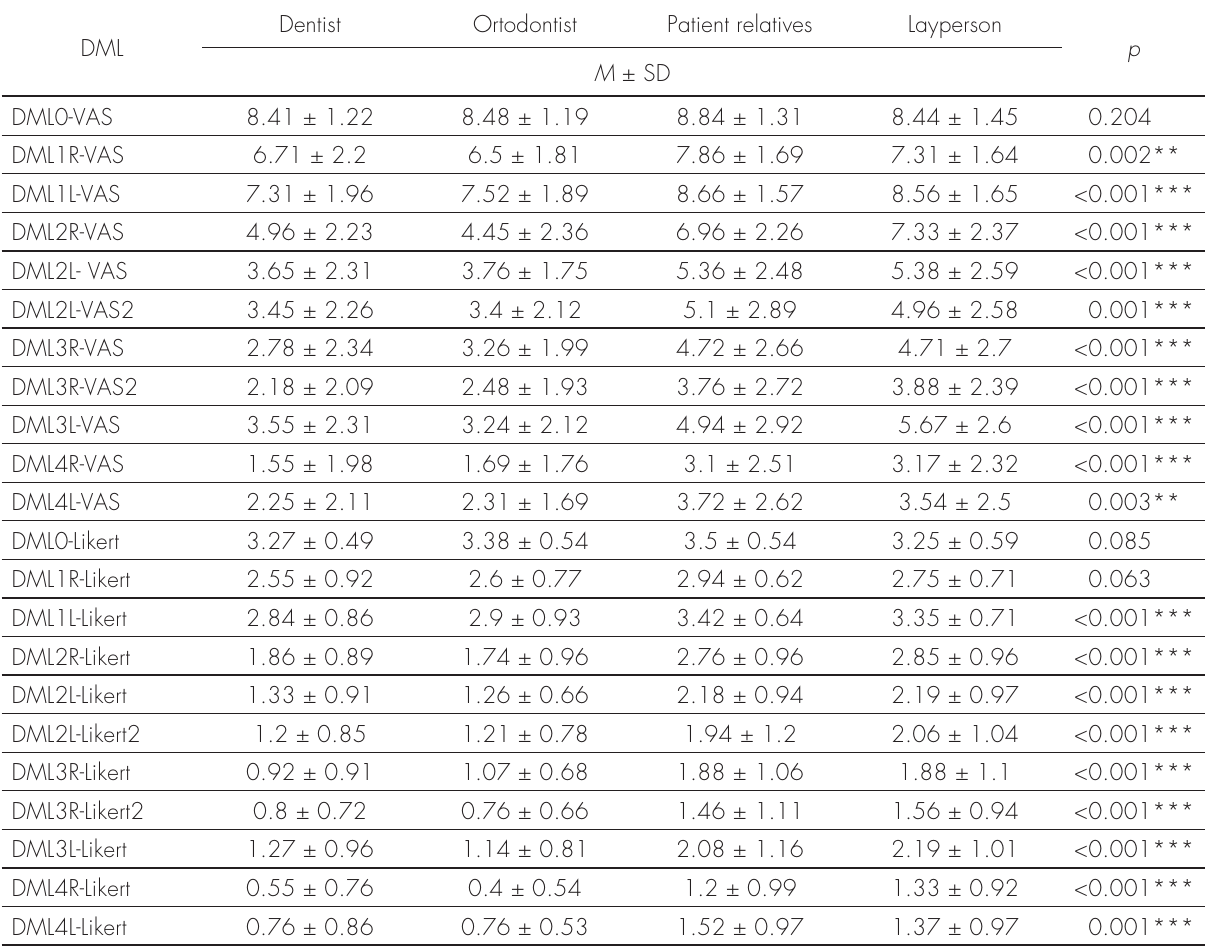
Table II. VAS and Likert scale scores according to occupational